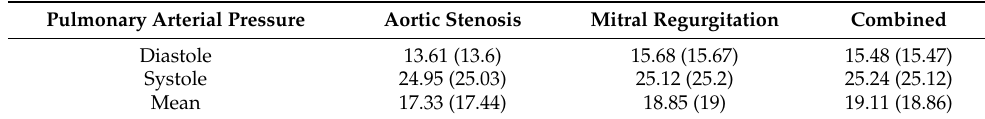
Figure 5. Pulmonary arterial and right ventricle pressure waveforms predicted by the model, along with predicted important PAP values using nominal model parameters. Solid lines—predicted values; markers—actual waveforms + noise. Table 8. Global results for diseased heart valve cases (values in parentheses are the true pseudo- measurement values).